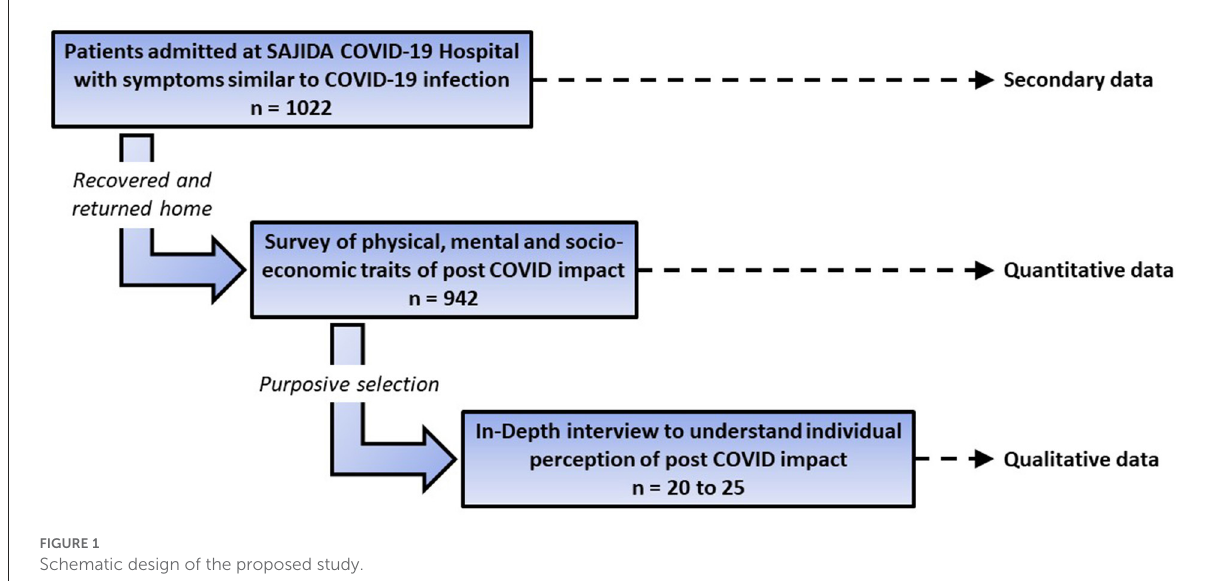
FIGURE1 Schematic design of the proposed